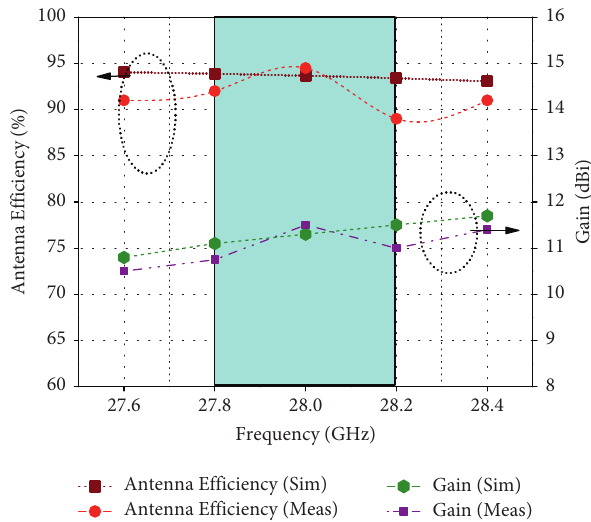
Figure 9: Simulated and measured array performance